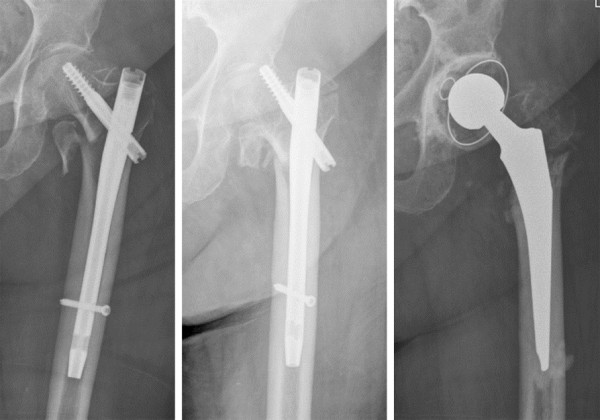
Patient with cutting out: postoperative, during follow-up and after revision with hip prosthesis.